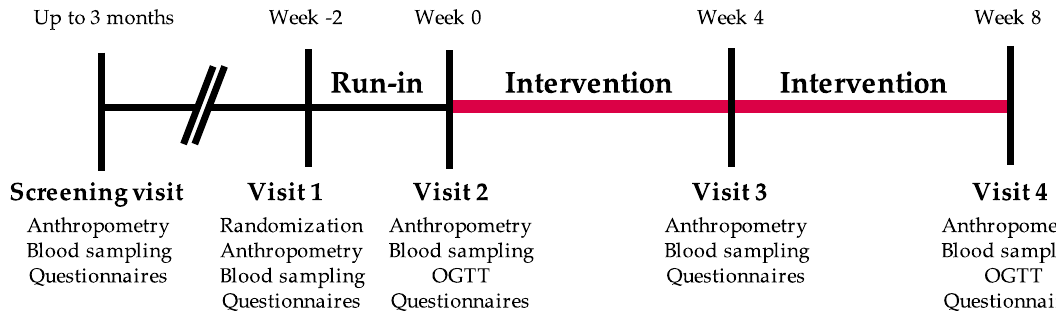
Figure 2. Graphical representation of the study protocol.